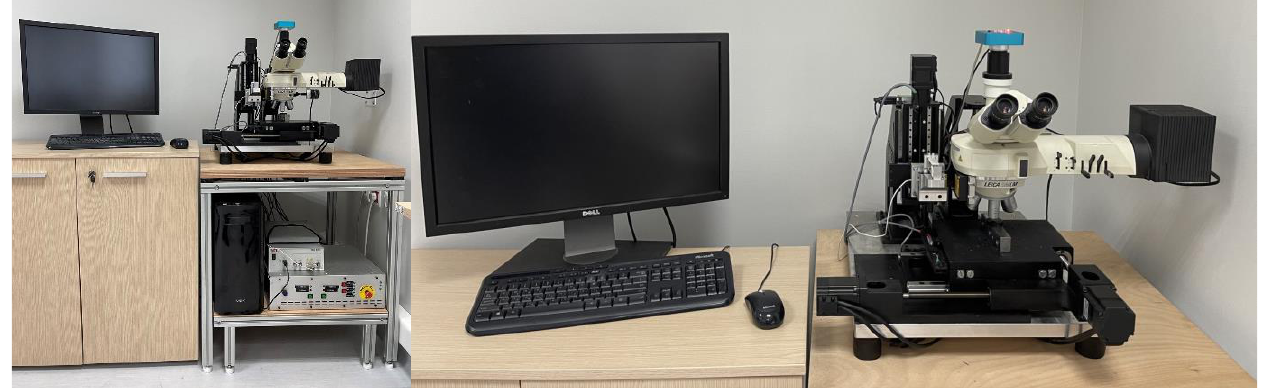
Figure 6. Nanoindentation test of nanocrystalline specimens according to ISO 14577.